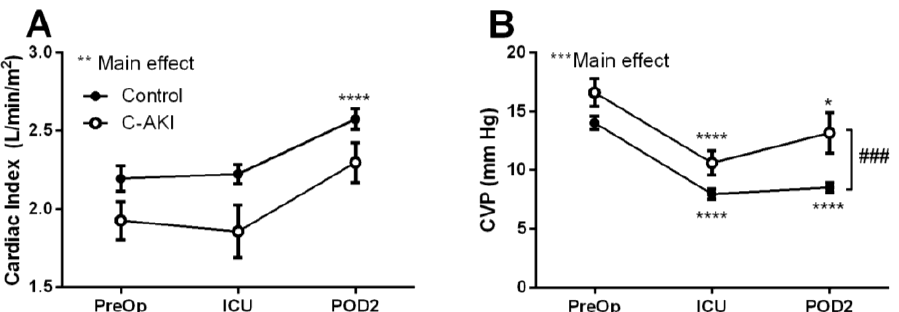
Figure 2. Cardiac index ( A ) and central venous pressure ( B ) in patients who developed congestive acute kidney injury (c-AKI) vs. controls. Hemodynamic variables were assessed preoperatively, upon admission to the intensive care unit and on postoperative day two. * Significantly different than baseline levels, p < 0.05; ** p < 0.01; *** p < 0.001; **** p < 0.0001. ### Significant difference between c-AKI and control, p < 0.001.